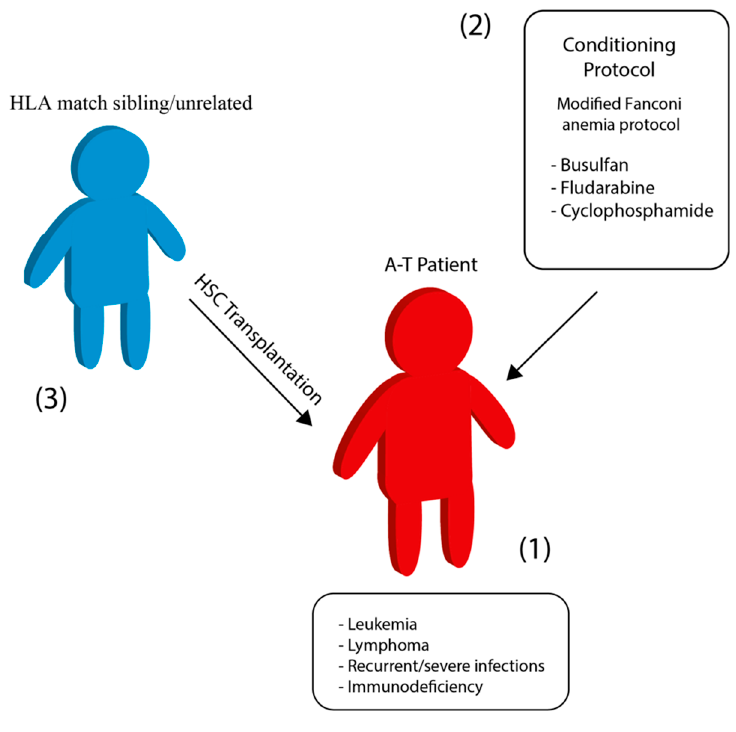
Figure 1. Hematopoietic stem cell transplantation in A-T patients. Young A-T patients with severe